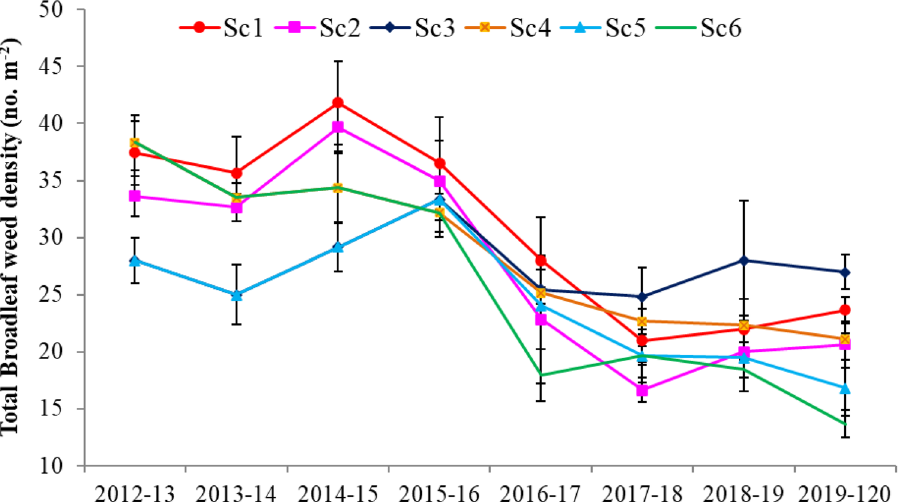
Figure 6. Total broadleaf weed density (no. m −2 ) trend influenced by climate-smart agriculture—based management practices under wheat crop. Vertical bars indicate ± SE of the mean. Sc1 conventional rice–wheat system with flood irrigation (FI), Sc2 conservation agriculture (CA)- based rice–wheat–mungbean system with FI, Sc3 partial CSA-based rice–wheat–mungbean system with FI, Sc4 partial CSA-based maize–wheat– mungbean system with FI, Sc5 full CSA-based rice–wheat–mungbean system with subsurface drip irrigation (SDI), Sc6 full CSA-based maize–wheat–mungbean system with SDI. The figure has been generate using Microsoft Excell office professional Plus (2010), version